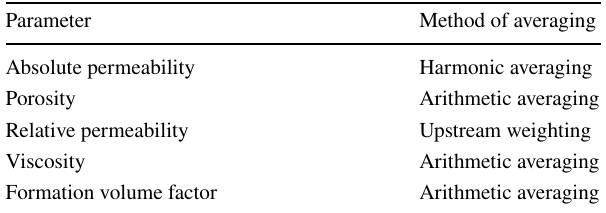
Table 1 Method of averaging